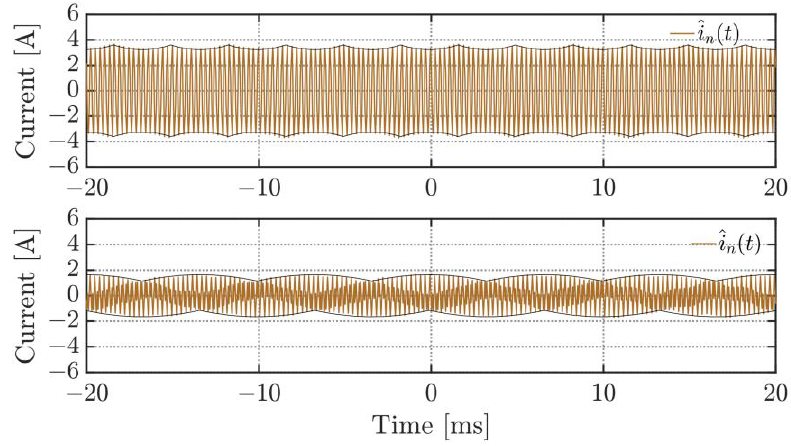
Figure 14. Instantaneous experimental neutral current ripples and theoretical envelopes (black lines) in case of a single ( top ) and three interleaved ( bottom ) carriers at modulation m = 0.4 and a switching frequency of 3.6 kHz.